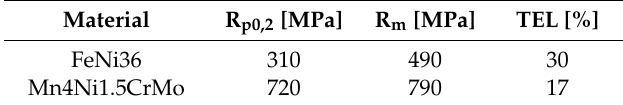
Figure 6. Hardness overview of the welded test piece measured in HV10. Table 2. Mechanical properties of una ff ected base material according to data